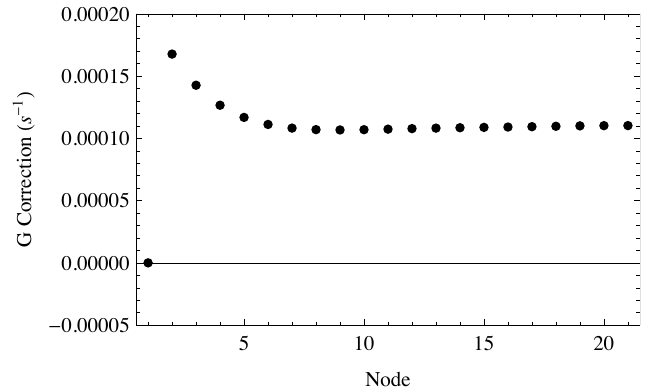
Figure 8. Nodal least-squares corrections, ∆ G , for each node based on results for an implicit simulation with G = 0.0001 s − 1 using output from the last two days of the 10.0-day simulation on the linear sloping domain. Observations are from the 2D CG ADCIRC code with G = 0.001 s − 1 .